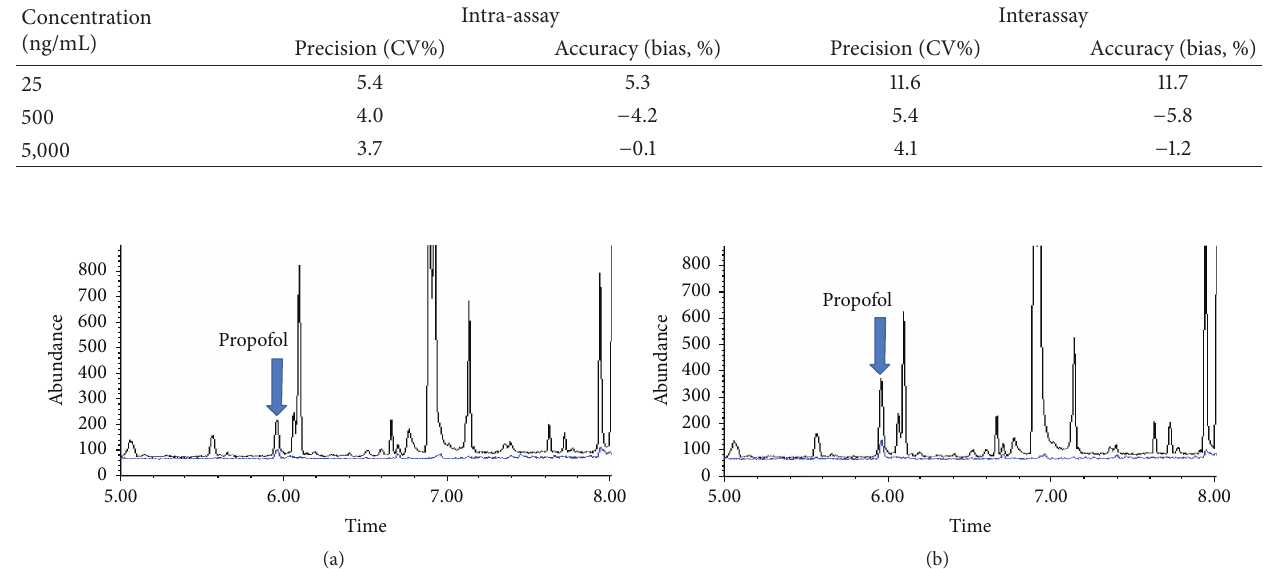
Figure 2: The representative extracted ion chromatograms of authentic heart plasma sample (a) and peripheral plasma sample (b).